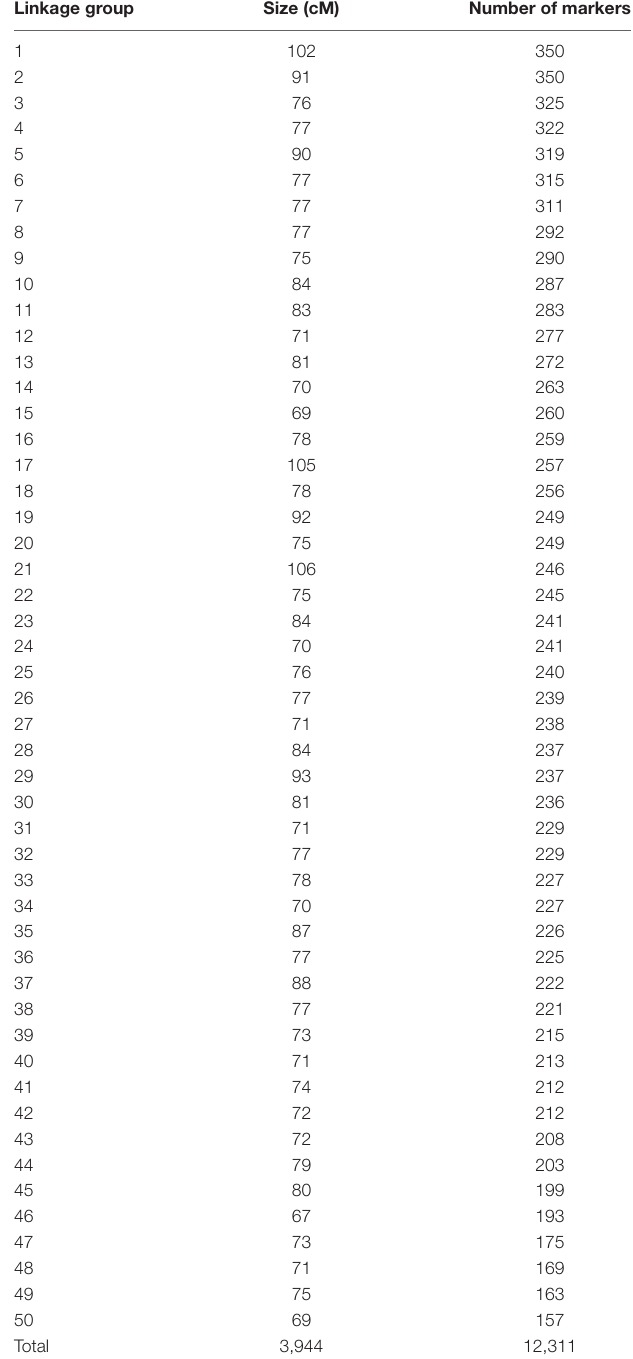
TABLE 1 | Number of QC-filtered SNPs per linkage